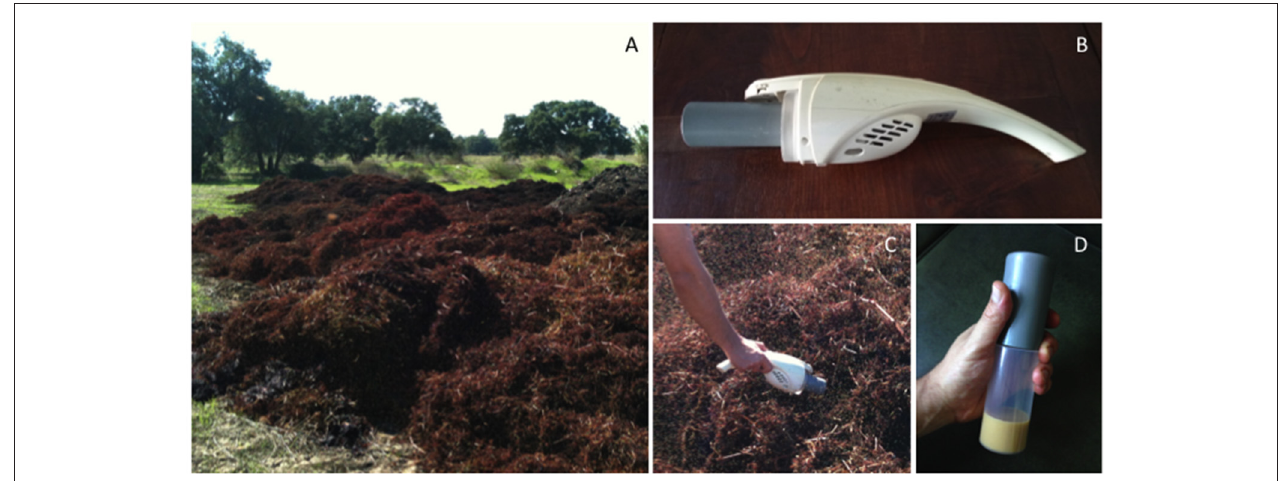
FIGURE 1 | Vineyards are large-scale collection sites for wild Drosophila specimens. (A) Winery dump site in Southern Portugal (B) portable vacuum cleaner coupled to a acrylic tube with a soft net (C) collecting a large number of individuals (D) flies are transferred directly to bottles containing standard fly food.